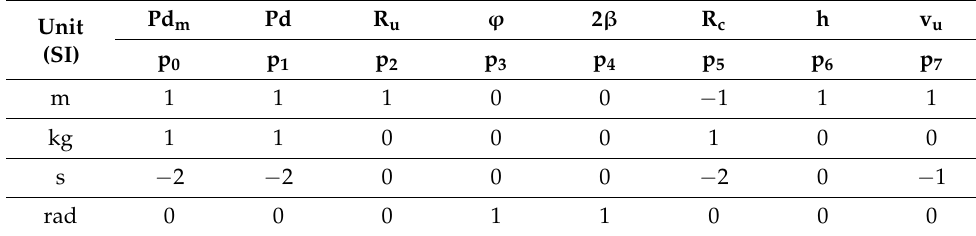
Table 1. Matrix of variables for determining the system of dimensionless